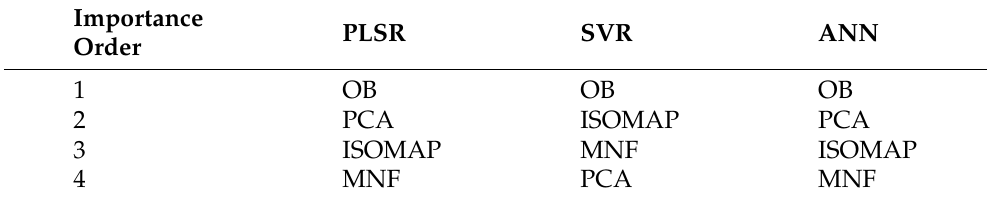
Table 4. Features importance in descreasing order for PLSR, SVR and ANN.